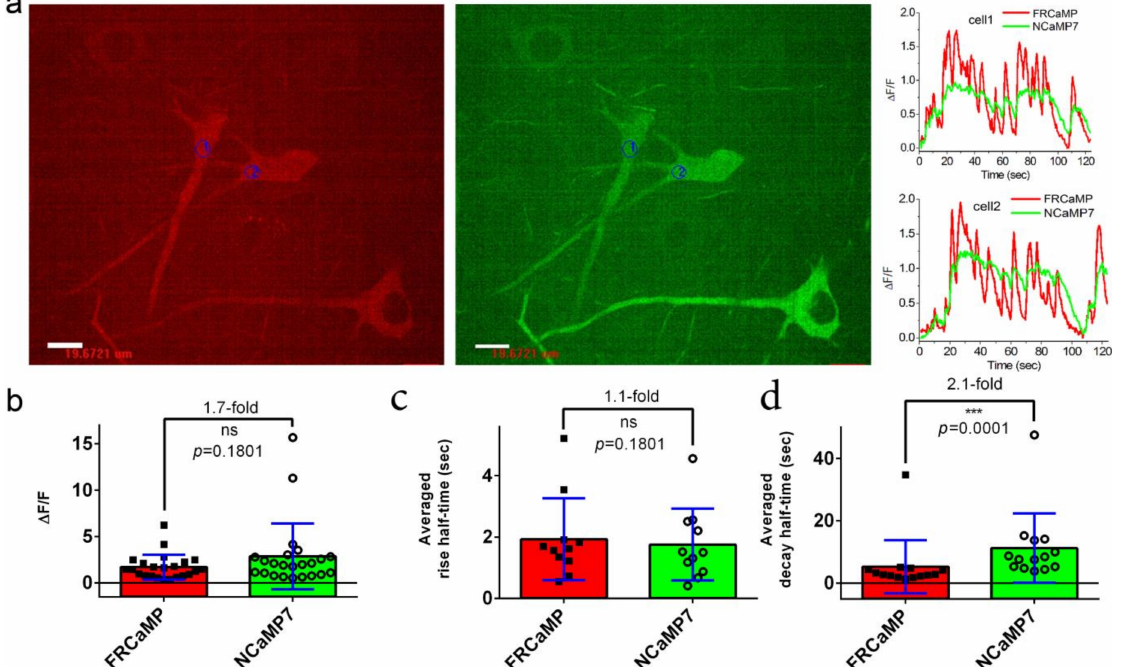
Figure 4. Two-color calcium imaging of the non-specific (spontaneous) activity of neuronal cultures co-expressing the red FRCaMP and green NCaMP7 indicators. Neuronal cultures were transduced on day in vitro (DIV) fourth with a mixture of rAAVs carrying the nuclear export signals (NES)-FRCaMP and NES-NCaMP7. ( a ) Confocal images of neuronal cultures co-expressing the NES-FRCaMP and NES-NCaMP7 indicators. Scale bar, 20 µ m. Examples of ∆ F/F traces for the two selected cells labeled with circles (see Figure S4 for more traces). Neuronal cultures co-expressing the NES-FRCaMP and NES-NCaMP7 indicators were imaged on DIV 15th. Average ∆ F/F responses ( b ), rise, and ( c ) decay ( d ) halftimes for the FRCaMP and NCaMP7 indicators. ( b – d ) Error bars are the standard deviations across 16 cells and 11–23 spikes. Ns, not significant; p , the level of statistical significance; ***, p -value is 0.0001 to